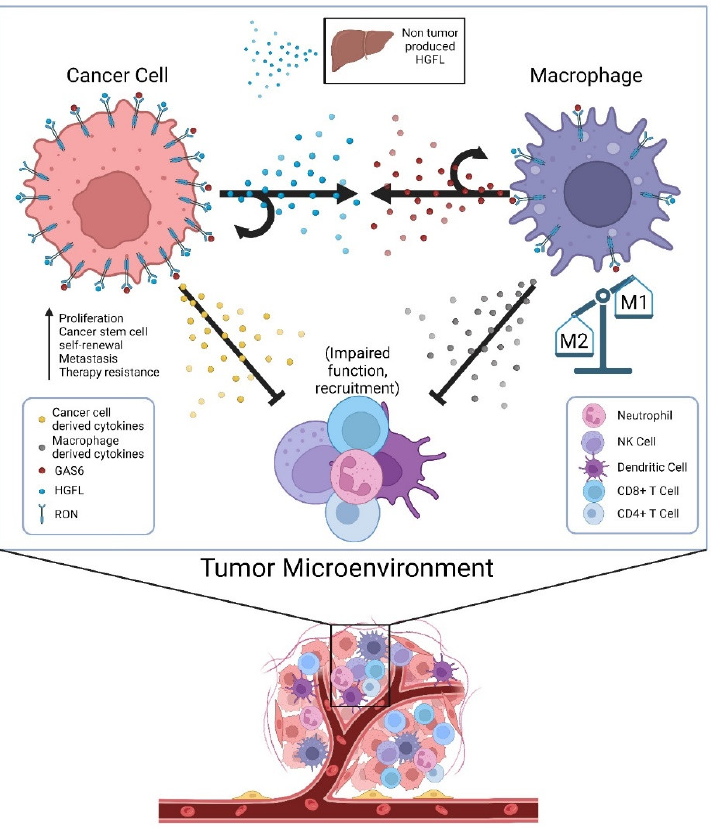
Figure 1. Cellular crosstalk of secreted factors in the tumor microenvironment (TME) that sustain high RON signaling in tumor cells and tumor-associated macrophages and alter the secretome to impair tumor immunogenicity. Physiologic sources of HGFL (primarily hepatocytes) provide a low level of HGFL for ligand activation, but tumor cells overexpress and produce high levels of HGFL to activate the abundant RON molecules on tumor cells in autocrine, and RON on the macrophages recruited to the TME. Tumor-associated macrophages secrete GAS6 providing its own means of RON activation on macrophages in autocrine and RON on tumor cells (and Axl where applicable). RON signaling in both tumor cells and tumor-associated macrophages alters the secretome of both cell types in manners that suppress innate and adaptive immune function, thus allowing for robust tumor growth. 13. Open Questions in the Field of RON Signaling Repeatedly, RON signaling has been shown to promote wound healing and the res- olution of inflammation. From a translational perspective, acute activation of RON signal- ing may provide a means to reverse or dampen inflammatory conditions. RON activation through HGFL poses challenges due to the proteolytic processing required for HGFL mat- uration. However, the prospective activation of RON signaling via GAS6, which does not require extracellular maturation steps, presents an alternative means of RON activation [110,111]. GAS6-mediated RON activation was first described in prostate cancer and has not yet been tested in comparison with HGFL activation in inflammation and wound heal- ing models. Further experimentation to demonstrate suppression of inflammation by GAS6-mediated RON signaling comparable to HGFL-mediated RON signaling is war- ranted. Moreover, GAS6 mediates activation of other receptor tyrosine kinases, including Axl, Tyro-3, and Mer, that are expressed in macrophages, epithelial cells, and more cell types, thus complicating the specificity of receptor activation [110,111]. Thus, the existing